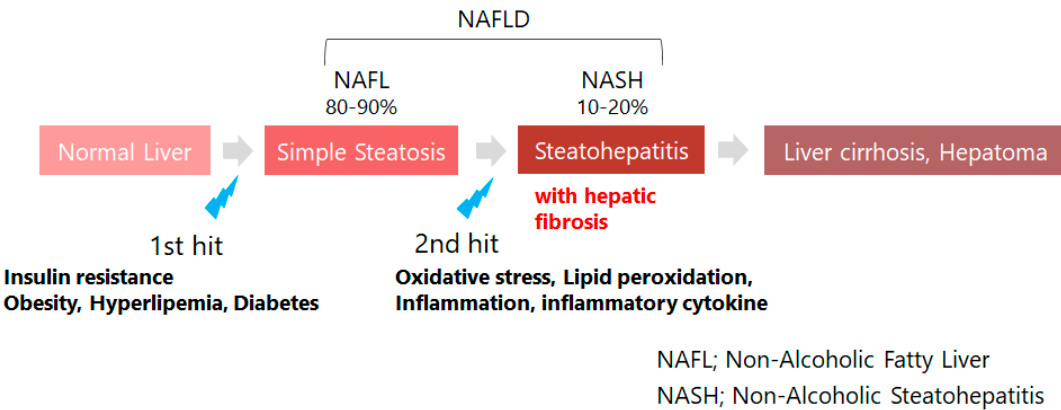
Figure 2. Non-alcoholic fatty liver disease (NAFLD) and its inducing factors: NAFLD is recognized as the hepatic phenotype of metabolic syndrome, which is closely related with lifestyle diseases such as obesity, type 2 diabetes, and disorder of lipid metabolism. The issue of concern is the acute increase in patients with obesity in the world. Metabolic disorder of retinoids (vitamin A) is observed in patients with impaired hepatic function including NAFLD, where almost 80% of retinoids are stored in hepatic stellate cells of human.